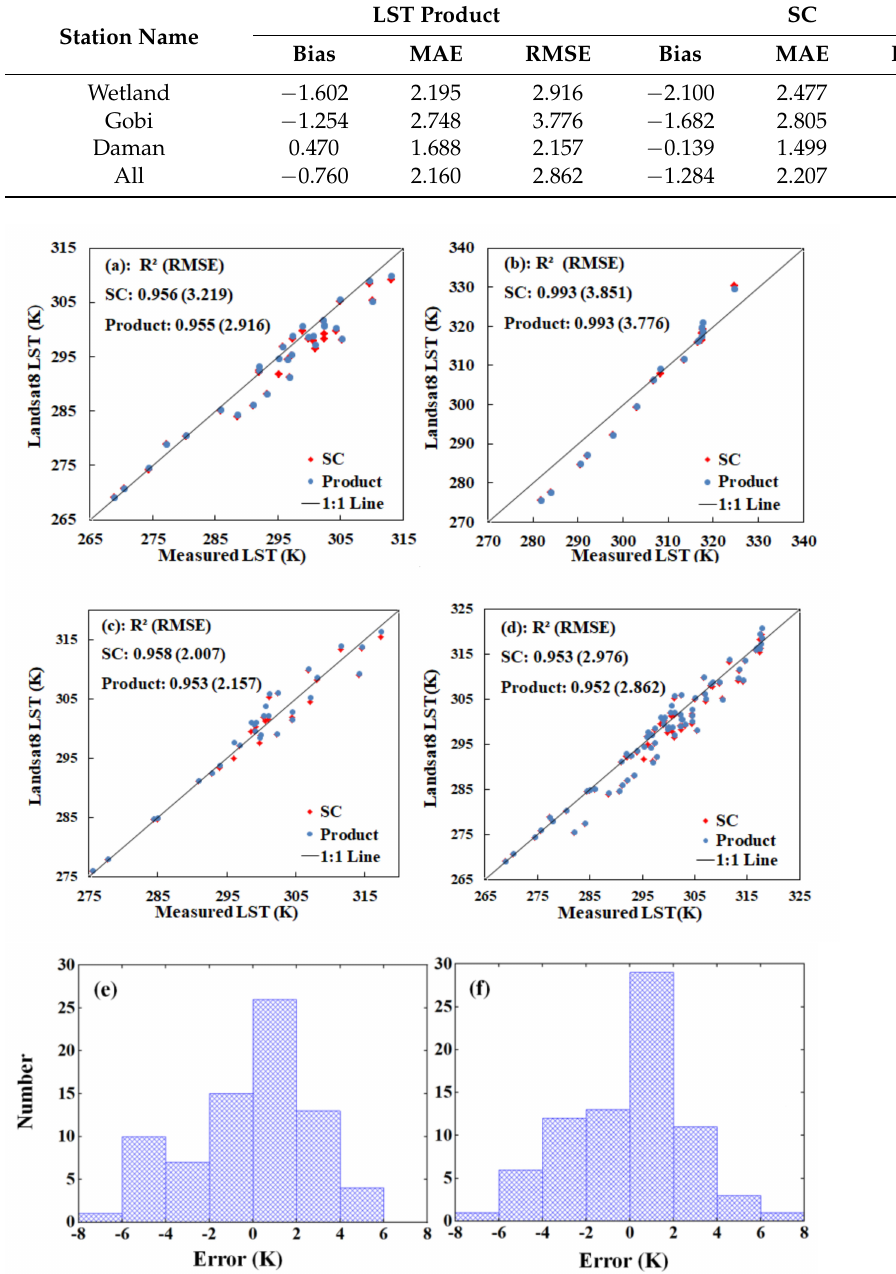
Figure 3. Scatter plot and error histogram of retrieved LST and measured LST. ( a ): Wetland station; ( b ): Gobi station; ( c ): Daman superstation; ( d ): All stations; ( e ): LST product error histogram at All stations; ( f ): SC error histogram at All